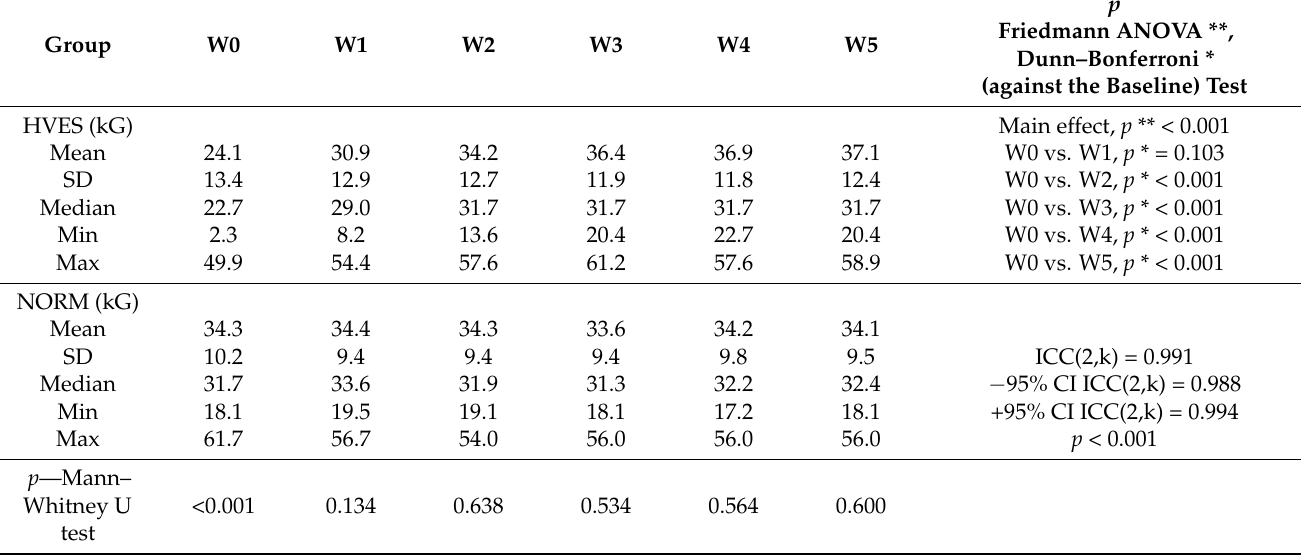
Table 2. The dynamometric measurement of the hand grip strength. ICC, interclass correlation coefficient model (for six trials of the hand grip strength). Abbreviations: W0, baseline (before treatment); W1, after treatment; W2, 3 weeks after treatment; W3, 6 weeks after treatment; W4, 12 weeks after treatment; W5, 24 weeks after